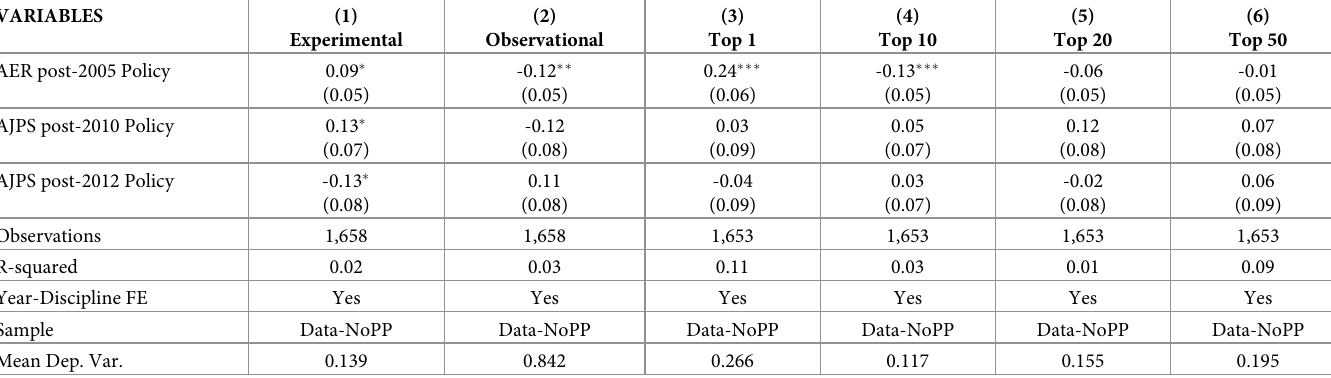
Table 4. Tests of the 2SLS exclusion restriction.